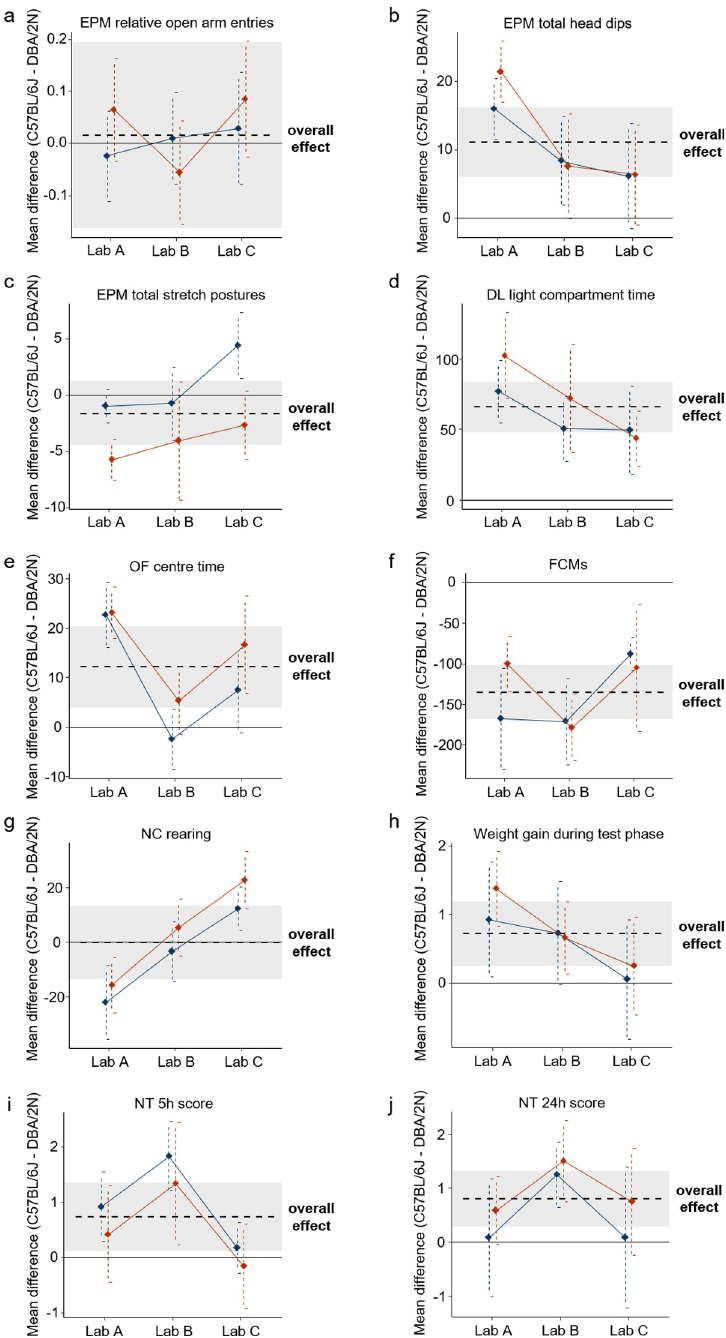
Fig 2. Variation of mean strain differences across the 3 laboratories in the standardised (red) and the heterogenised design (blue). Shown are the mean strain differences of C57BL/6J and DBA/2N mice in the order of testing in (a) “relative open arm entries in the EPM” (b) “total head dips in the EPM” (c) “total stretched postures in the EPM” (d) “light compartment time in the DL test” (e) “OF centre time” (f) “FCMs concentrations” (g) “amount of rearings in the NC test” (h) “weight gain during test phase” (i) “NT test score after 5 h” and (j) “NT test score after 24 h”. The black dashed line and the shaded area indicate the overall mean strain difference of this outcome measure and its corresponding CI 95 . The black solid line reflects a null effect. Dots and vertical dashed lines reflect the mean strain differences and corresponding CI 95 of the results from the 3 laboratories in each design. The raw data underlying this figure are available in the Figshare repository https://figshare.com/s/f327175aa8b541ef01bd. CI 95 , 95% confidence interval; DL, Dark Light; EPM, Elevated Plus Maze; FCMs, faecal corticosterone metabolites; NC, Novel Cage; NT, Nest; OF, Open Field. https://doi.org/10.1371/journal.pbio.3001564.g002 PLOS Biology | https://doi.org/10.1371/journal.pbio.3001564 May 5,